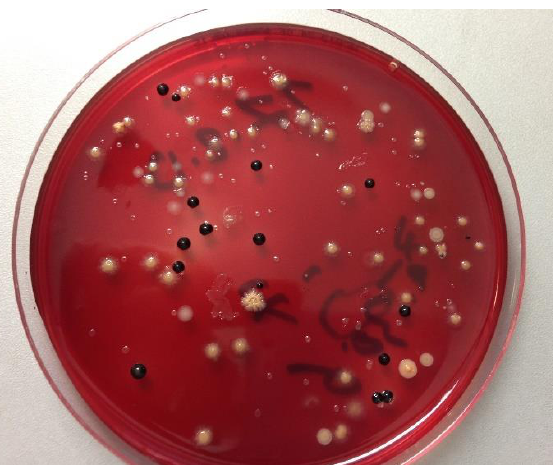
Figure 1. Anaerobic bacteria in culture. Different bacterial colonies which were anaerobically cultured from total salivary bacteria on an HCB agar plate for 10 days.